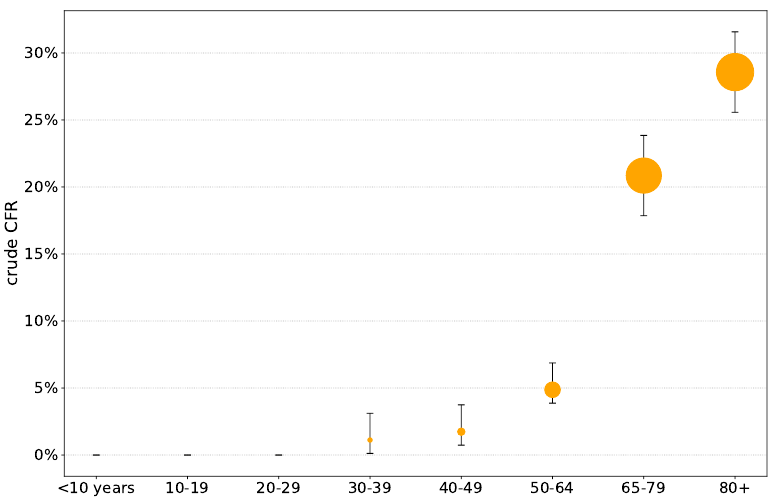
Figure 4. Crude case fatality rate of confirmed COVID-19 cases in Hungary by age groups (reported until May 10, 2020. Data source: